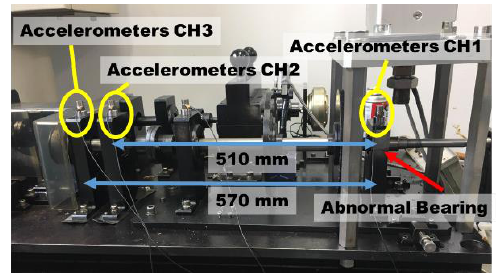
Figure 7. Rotating machine for experimental equipment simulating as a pump facility.